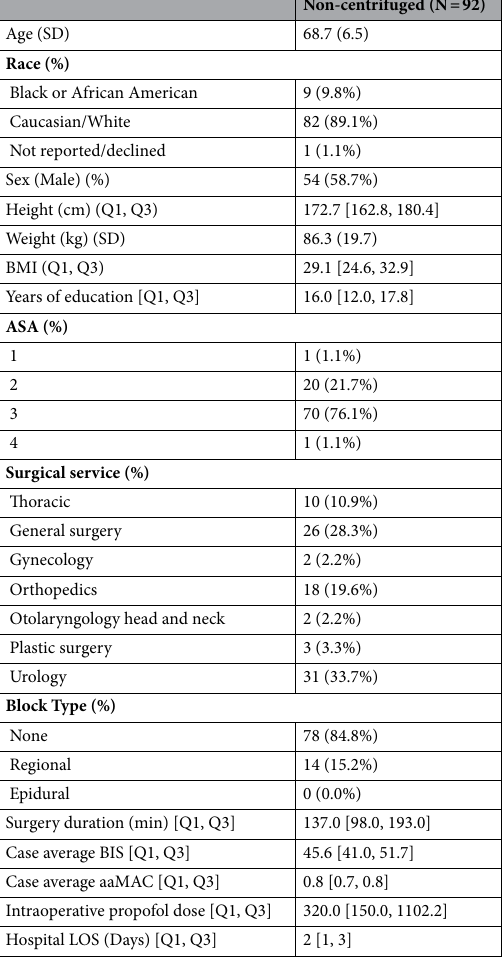
fuged CSF pellet samples and supernatants from another 20 MADCO-PC study patients (Table 2). LC–MS data for individual lipid mediators in centrifuged CSF pellets and supernatants were analyzed using 2-way repeated measures ANOVAs in R (version 4.0.0). Post hoc tests included testing for factor interactions and Tukey’s Honestly Significant Difference (HSD) test. For individual lipid analytes, family-wise error rate was corrected using the Bonferroni correction.